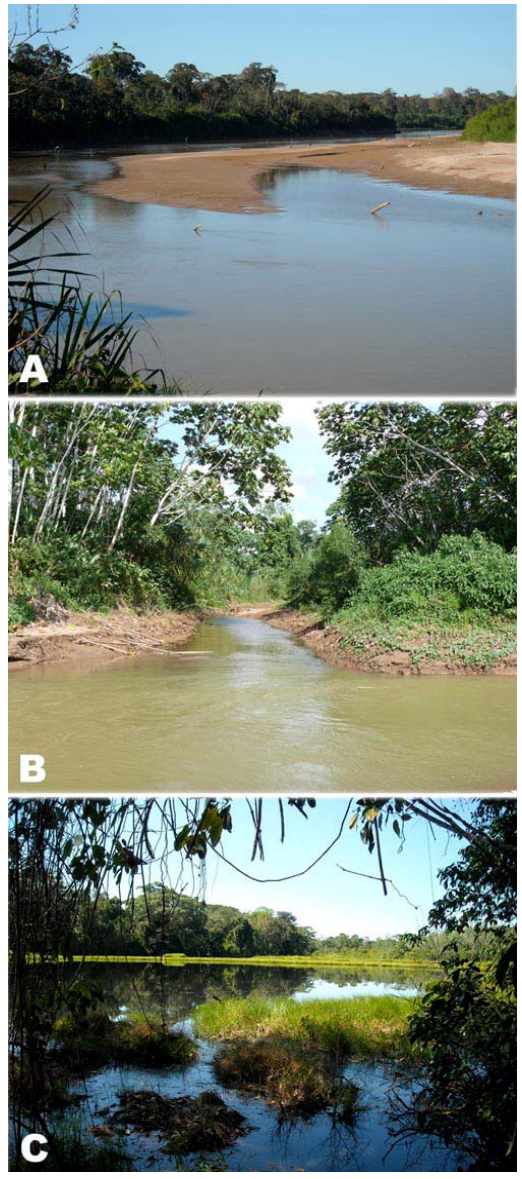
Figure 11. Examples of the three major aquatic habitats sampled in the Fitzcarrald region. (A) Channel and flooded beaches of the Rio Purús at San Marcos (9°53'S 70°52'W). (B) A stream emptying into the Mishaua river in the Urubamba basin (11°13'S 72°58'W). (C)